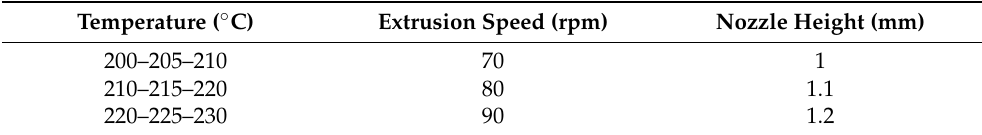
Table 2. Printing parameters were used to 3D print twenty-seven single beads.